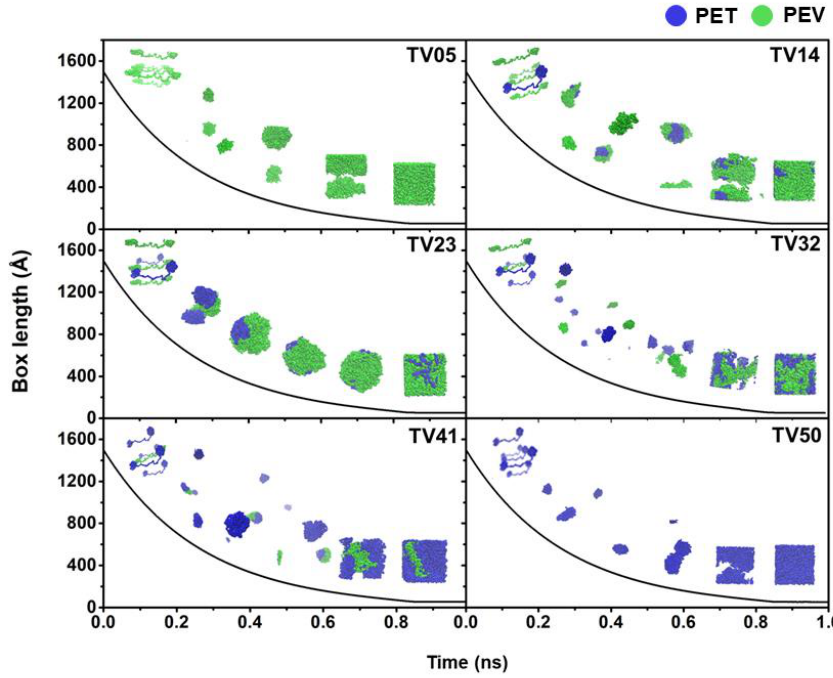
Figure 2. The folding conformations of PET, PEV, and their blend polymers along simulation time of 1.0 ns at 600 K and 250 atm.